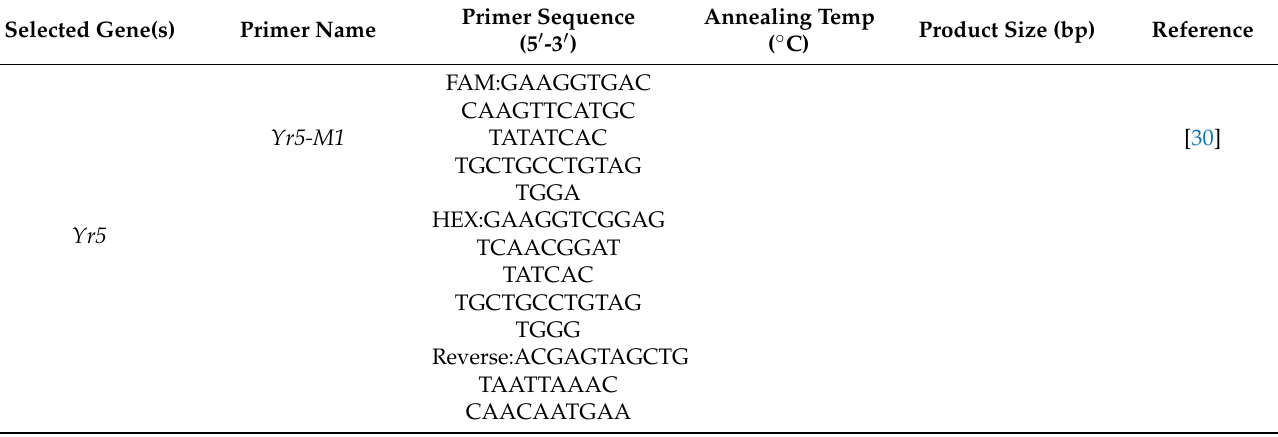
Table 1. Primers used to detect Yr, Pm , and Fhb resistance genes in the Huang-Huai-Hai region of China wheat cultivars